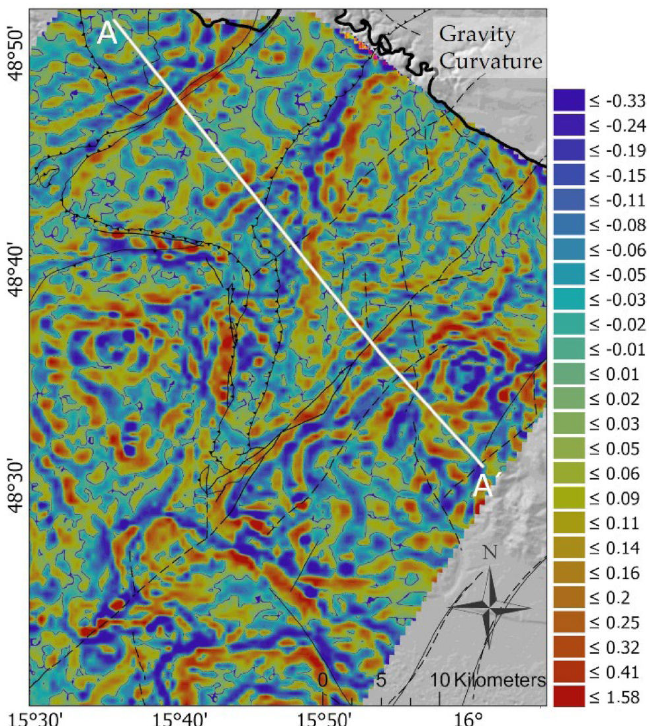
Figure 9. Profile curvature map of Bouguer anomaly data. Background map: Lidar image with a 10 × 10 m